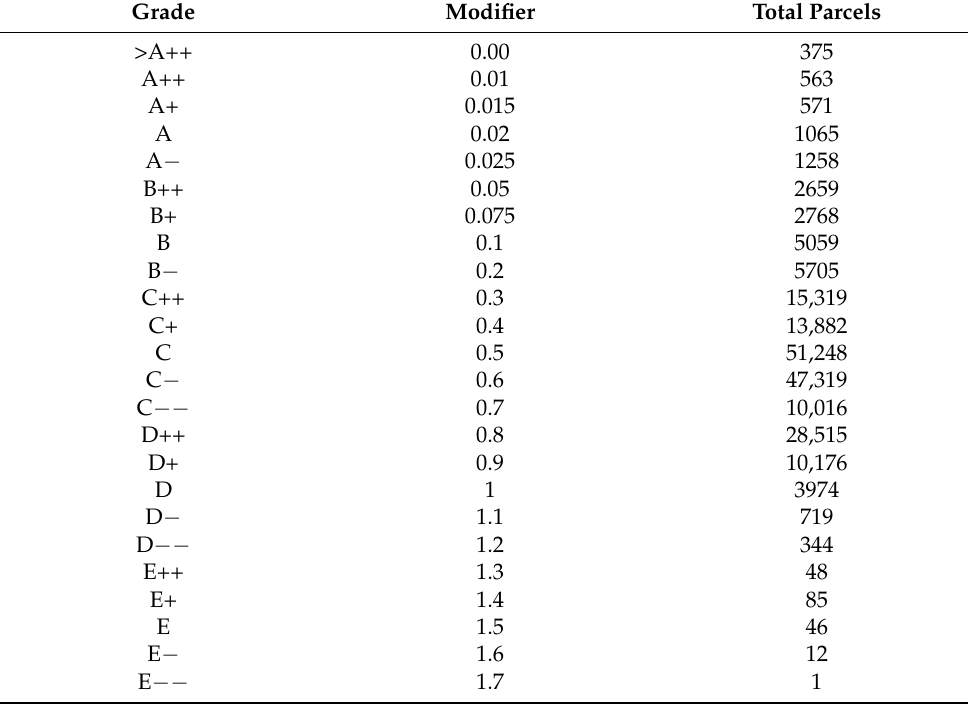
Table A2. Risk modifier based on building quality